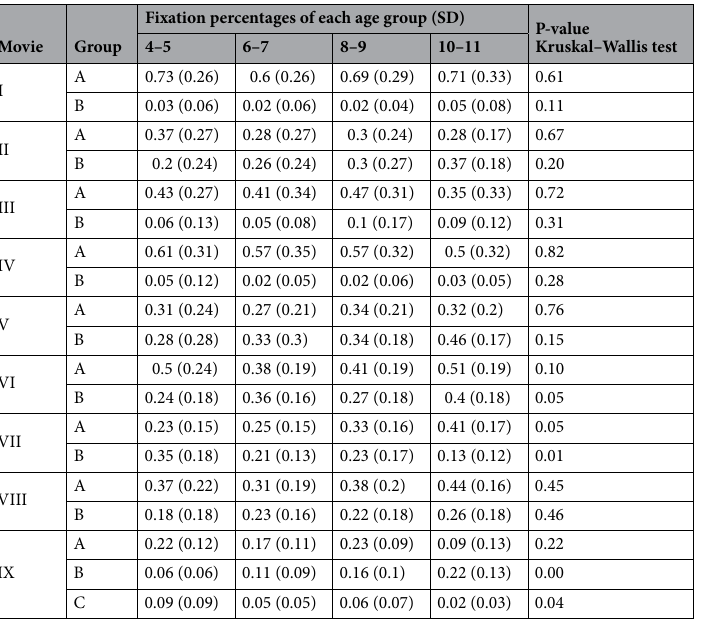
Table 4. Fixation percentage of each age group in I–IX Movies. Movie I–V; human face; (I) eye blinking; (II) mouth moving; (III) still image; (IV) silent; (V) talking; Movie VI; biological motion; Movie VII; human and geometric patterns (same size) VIII; human and geometric patterns (small window), Movie IX; joint attention. Group A (eyes)/Group B (mouth) in Movie I–V; Group A (upright)/Group B (upside down) in movies VI; Group A (person)/Group B (geometric pattern) in Movie VII–VIII; Group A (person)/Group B (pointed object)/Group C (geometric pattern) in Movie IX. SD standard deviation.